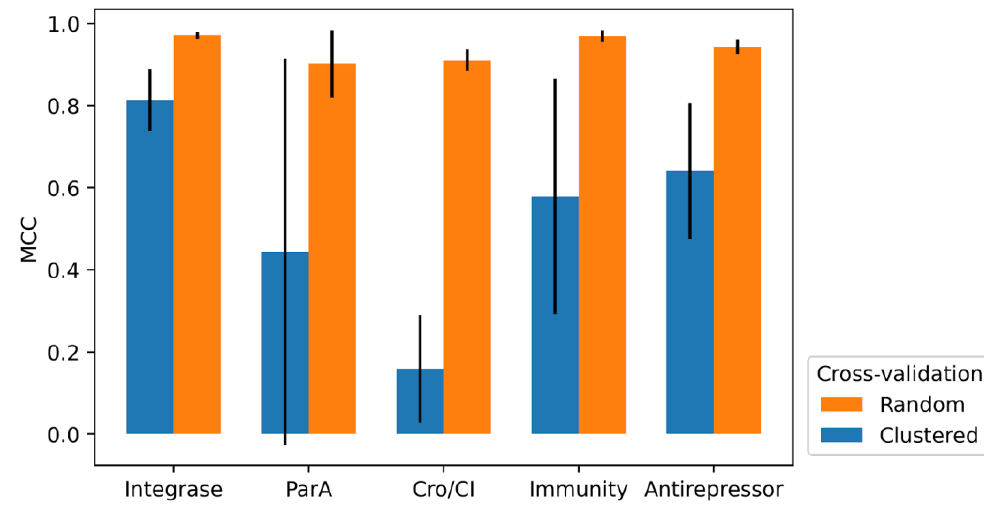
Figure 7. Mean MCC of random 10-fold cross-validation and clustered 10-fold cross-validation.